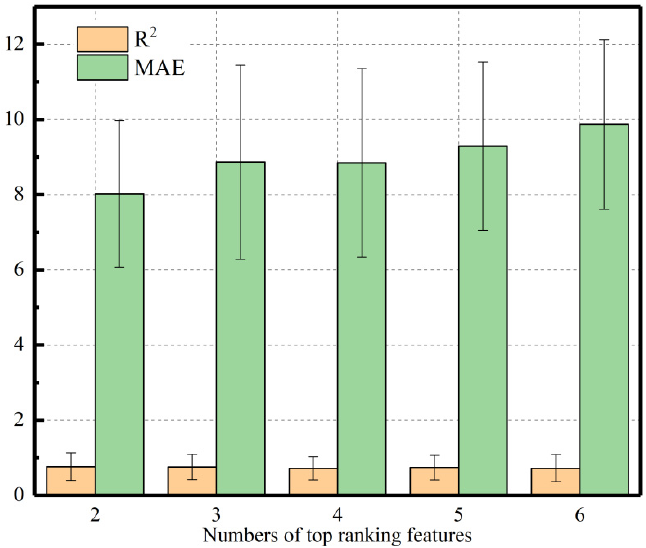
Figure 8. The R 2 and MAE results of ranking feature combinations in 100 training sessions.